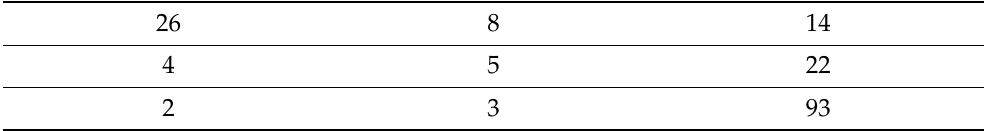
Table 13. Confusion matrix for Word2Vec embedding with the RFE (RF) feature selection method; 100 features.